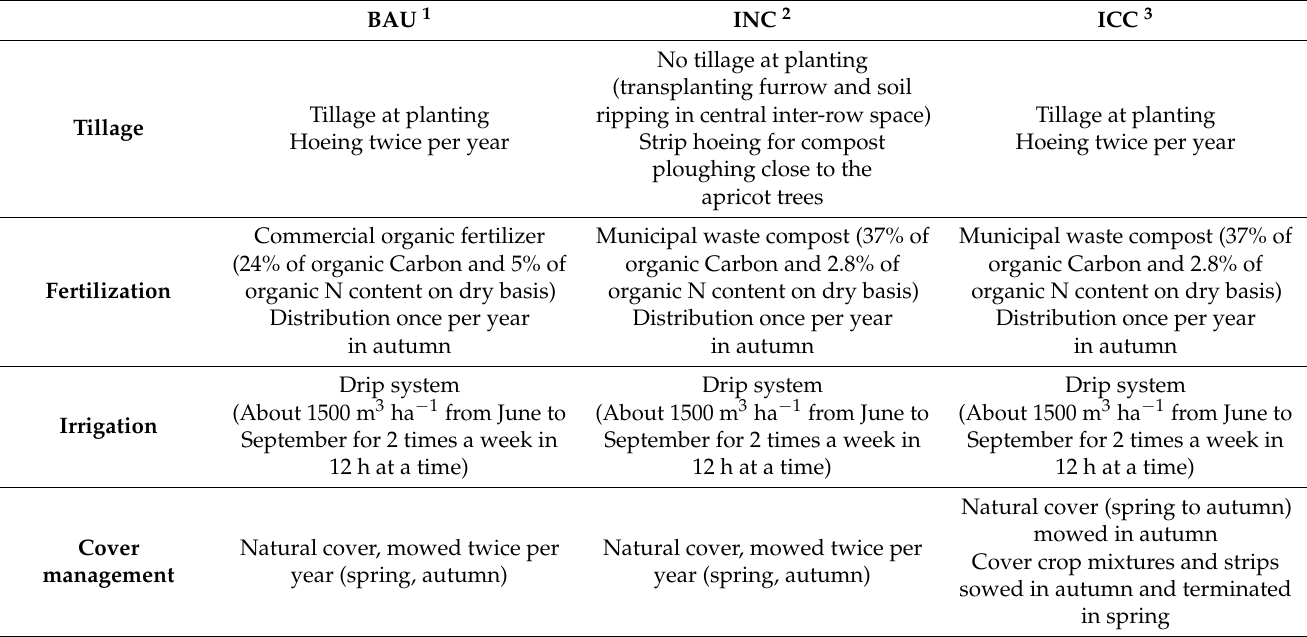
Table 1. Different agronomic system management